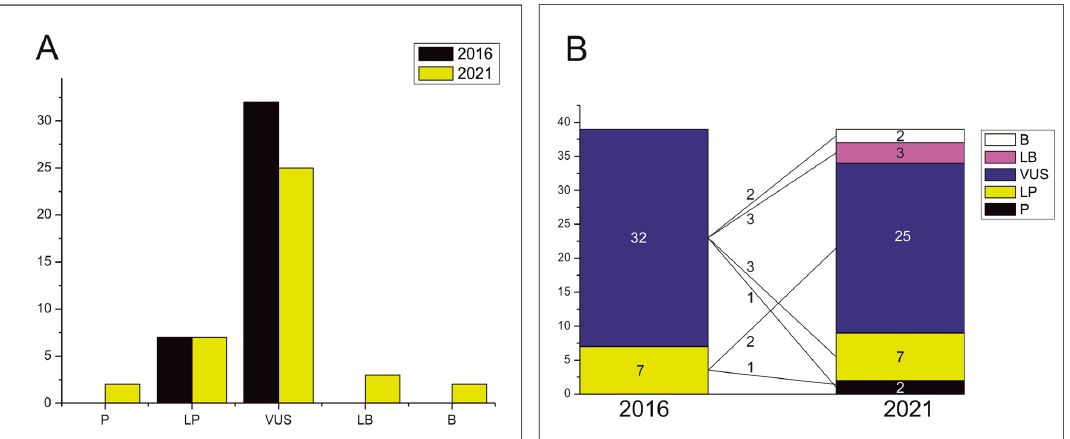
Figure 2. Distribution of the 39 revaluated variants into five groups of variant significance *. ( A ) Comparison of the number of variants in each group of significance. ( B ) Comparison of the number of variants between 2016 and 2021 classifications. * Five groups of variant significance: P = pathogenic; LP = likely pathogenic; VUS =variant of uncertain significance; LB = likely benign, and B = benign.